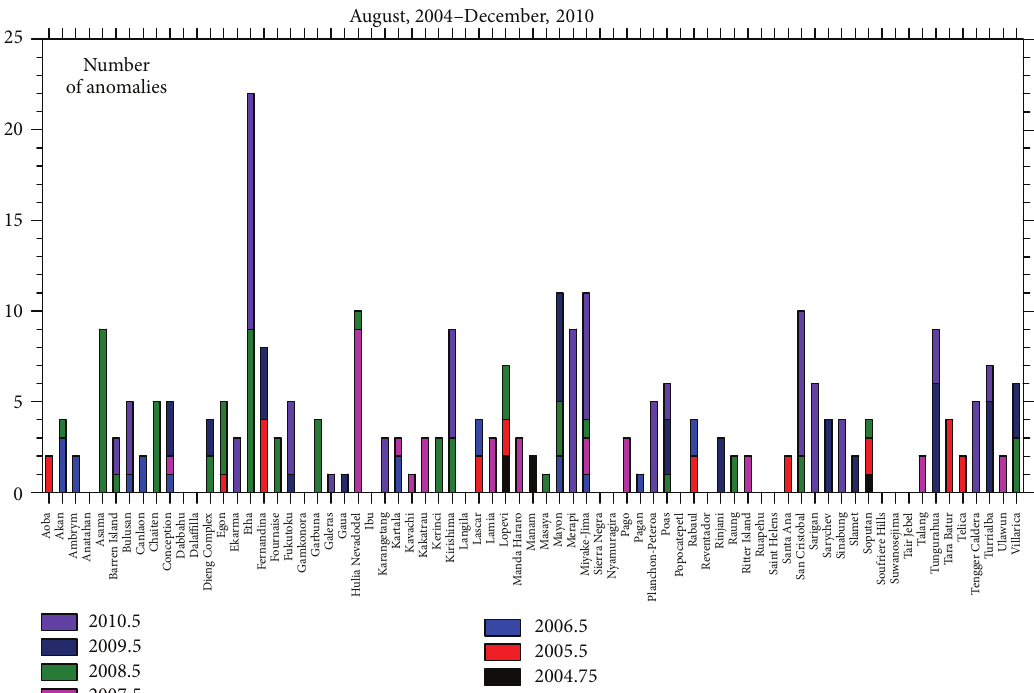
Figure 3: Bar chart of the number of anomalies recorded per year for each of the 73 volcanoes which have entered into eruption between August 2004 and December 2010 (note that 2004 data are computed between August and December).